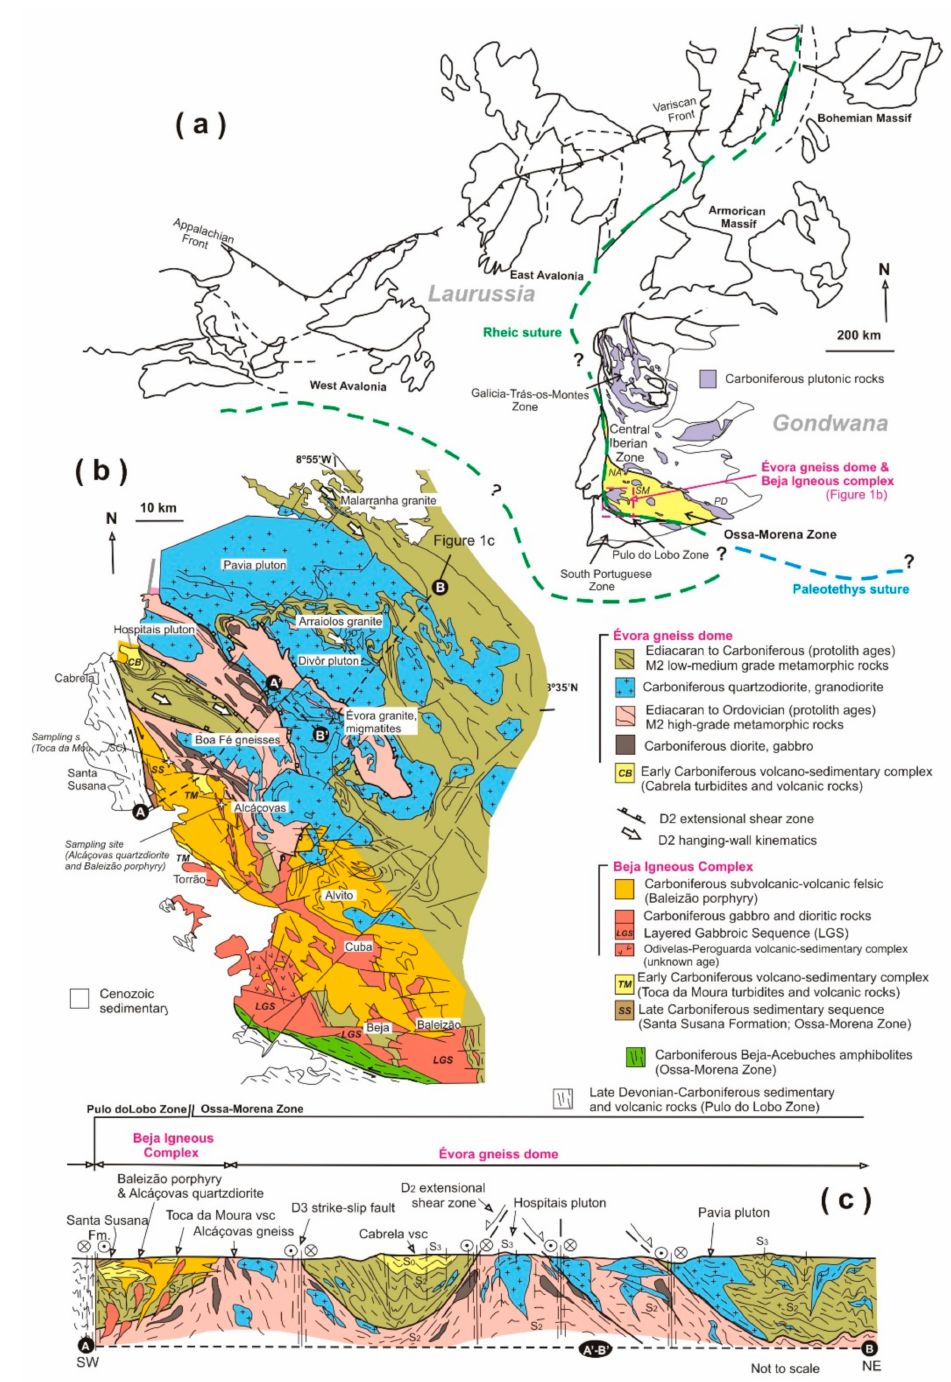
Figure 1. ( a ) Inset with the schematic location of Iberia in the Appalachian-Variscan belt in early Mesozoic times (adapted from [18]); location of the Beja Igneous Complex and the É vora gneiss dome (Ossa-Morena Zone, SW Iberia) in a schematic map showing the main Paleozoic tectonic units of Iberia. ( b ) Schematic geological map of the Beja Igneous Complex and the É vora gneiss dome (adapted from [33]). ( c ) Schematic cross-section through the É vora gneiss dome, Beja Igneous Complex and the tectonic boundary with the Pulo do Lobo